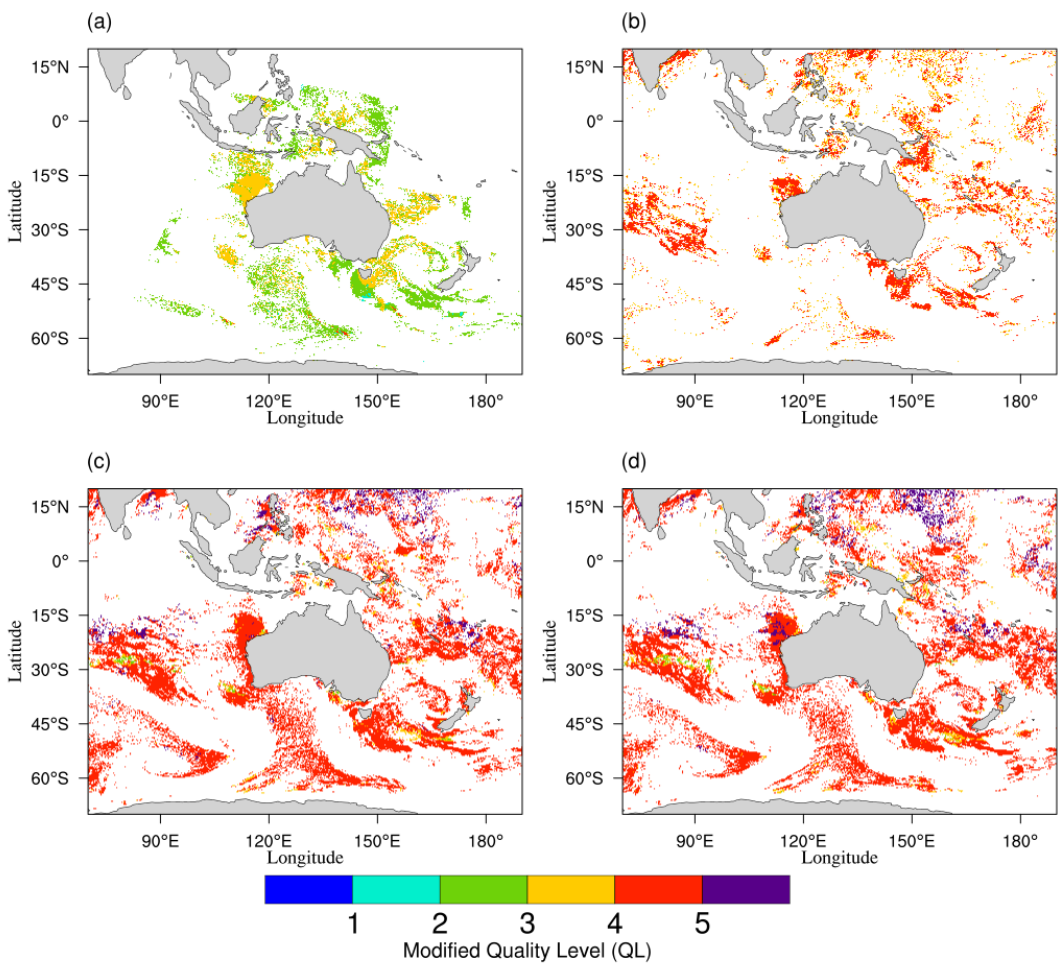
Figure 2. Modified quality level (QL) as per Section 2.2.5 for the fv02 L3C-1day daytime file for ( a ) NOAA-18 AVHRR, ( b ) MetOp-B AVHRR, ( c ) NPP VIIRS and ( d ) N20 VIIRS for 12 December 2018, obtained from